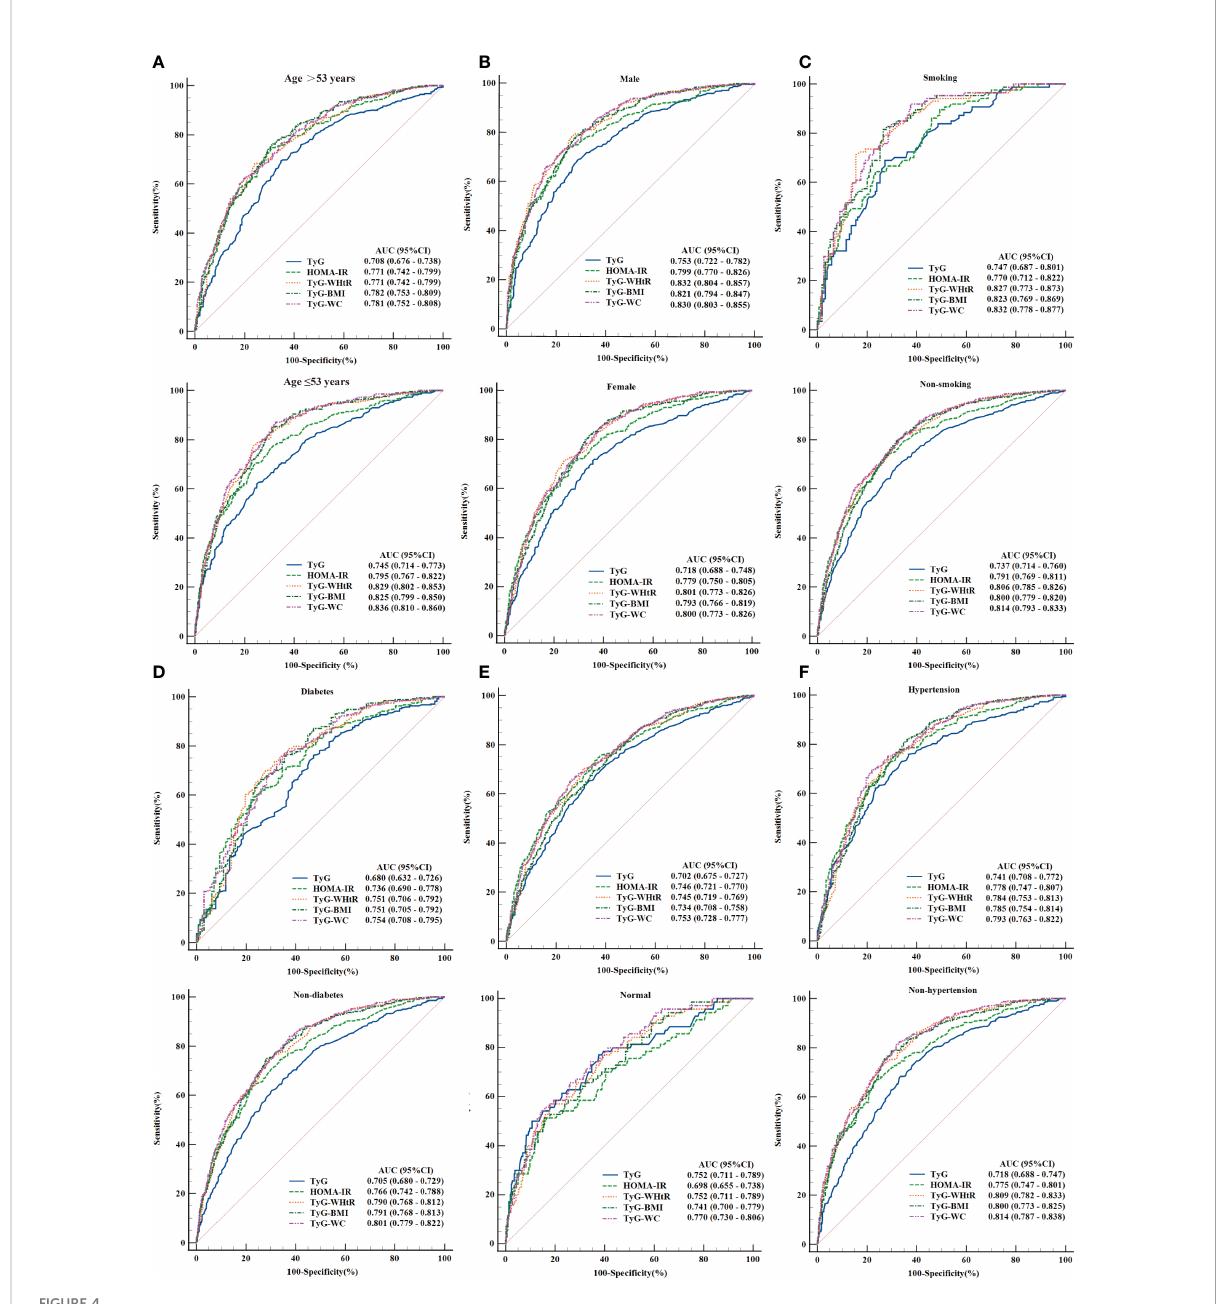
FIGURE 4 ROC curves and the area under the ROC curve (AUC) values of TyG index, HOMA-IR score, TyG-WHtR, TyG-BMI, and TyG-WC for NAFLD. (A) Subgroup analyses based on age. (B) Subgroup analyses based on gender. (C) Subgroup analyses based on smoking status. (D) Subgroup analyses based on diabetes. (E) Subgroup analyses based on overweight or obesity. (F) Subgroup analyses based on